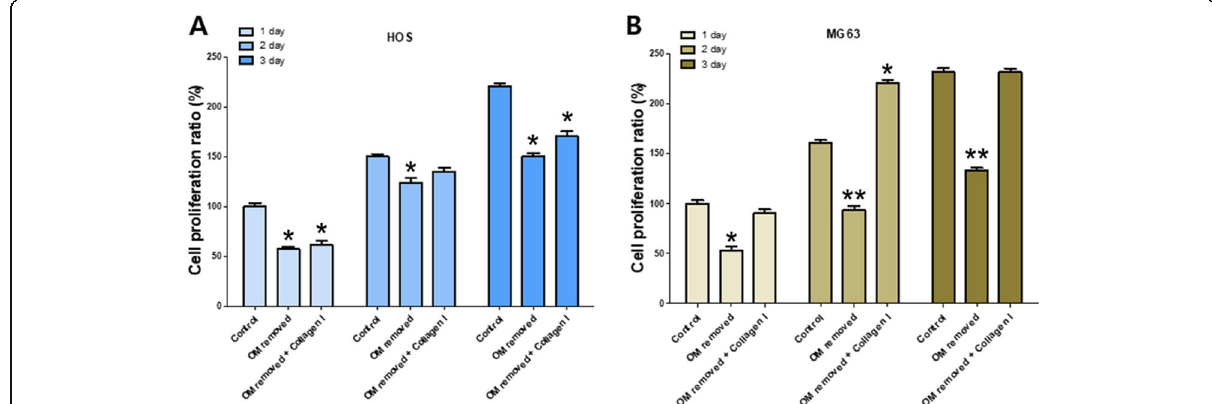
Fig. 5 A graph showing the time-dependent cell proliferation rate of HOS cells ( A ) and MG63 cells ( B ). Each value represents the mean ± S.D. * p < 0.05, ** p < 0.01 compared with control